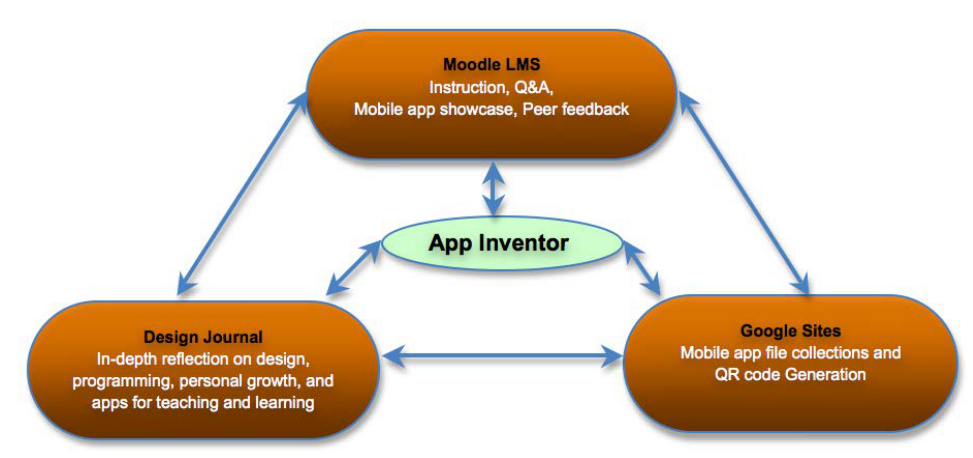
Figure 3. The integration of learning environments in the online course in mobile app